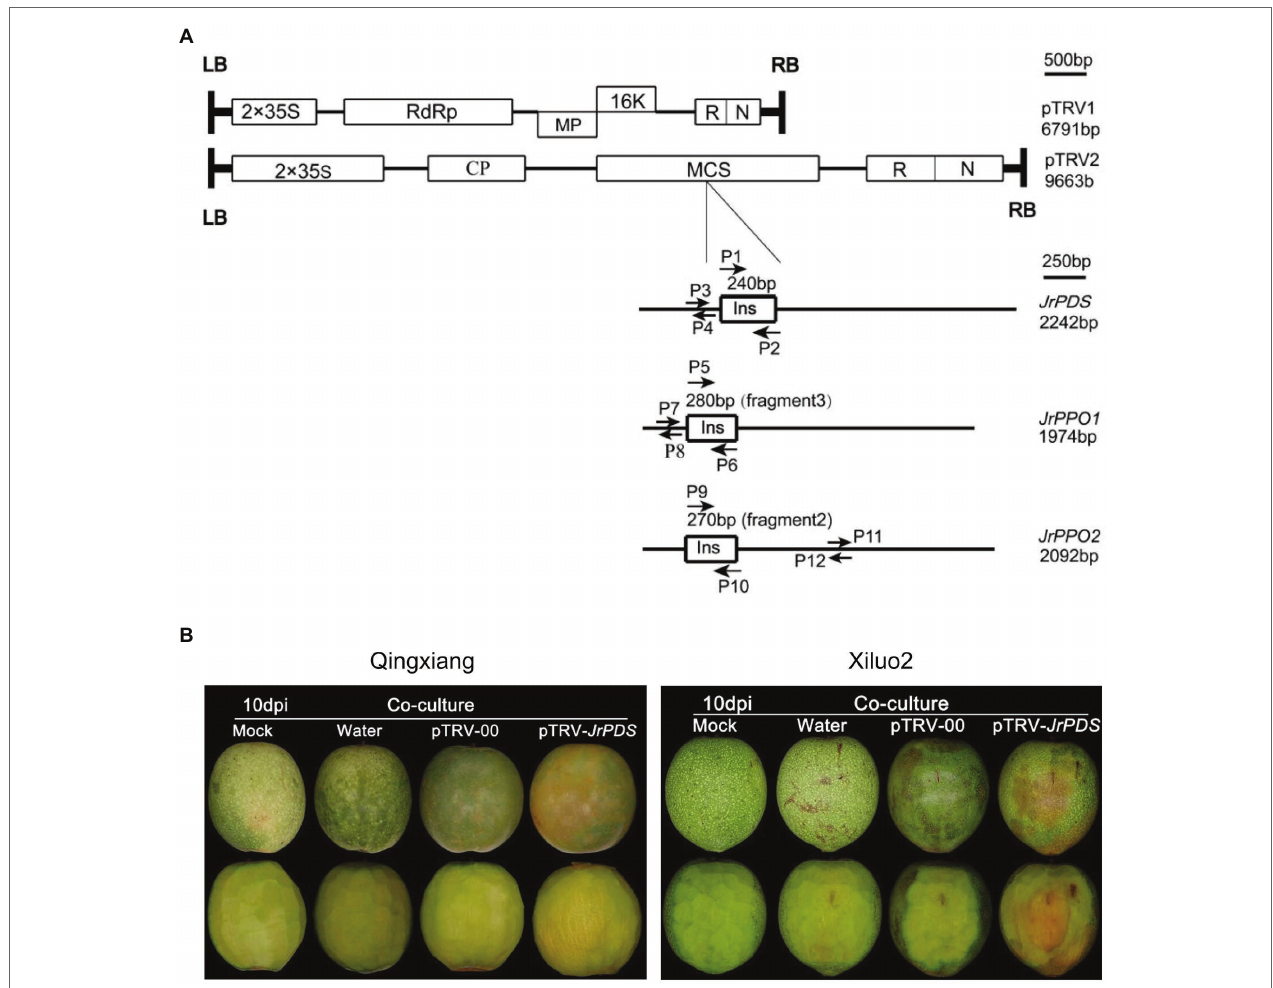
FIGURE 1 | VIGS-TRV system construction and JrPDS silencing in Juglans regia fruits. (A) Genomic organization of the two TRV components, pTRV1 and pTRV2, drawn to a scale of 500 bp. Boxes indicate Open reading frames (ORF). Schematic representation of cDNA full-length for JrPDS and JrPPOs (black line) drawn to scale of 250 bp. The 240-bp fragment of JrPDS , the 280-bp fragment3 of JrPPO1 , and the 270-bp fragment2 of JrPPO2 indicated by boxes are inserted in pTRV2. P1 and P2, P5 and P6, P9 and P10 are primer sets for generating pTRV- JrPDS and pTRV- JrPPO recombinants. P3 and P4, P7 and P8, P11 and P12 are primer sets for qRT-PCR analysis of JrPDS and JrPPOs transcripts. (B) Silencing JrPDS in J. regia fruits using the pTRV- JrPDS . TRV vectors induced photobleaching phenotype at 10 days post-inoculation (dpi), while mild mosaic symptoms appeared on fruits infected with pTRV-00, watery lesions on water control, no changes emerged on mock fruits. TRV, tobacco rattle virus; VIGS, virus-induced gene silencing; and qRT-PCR, quantitative reverse transcription